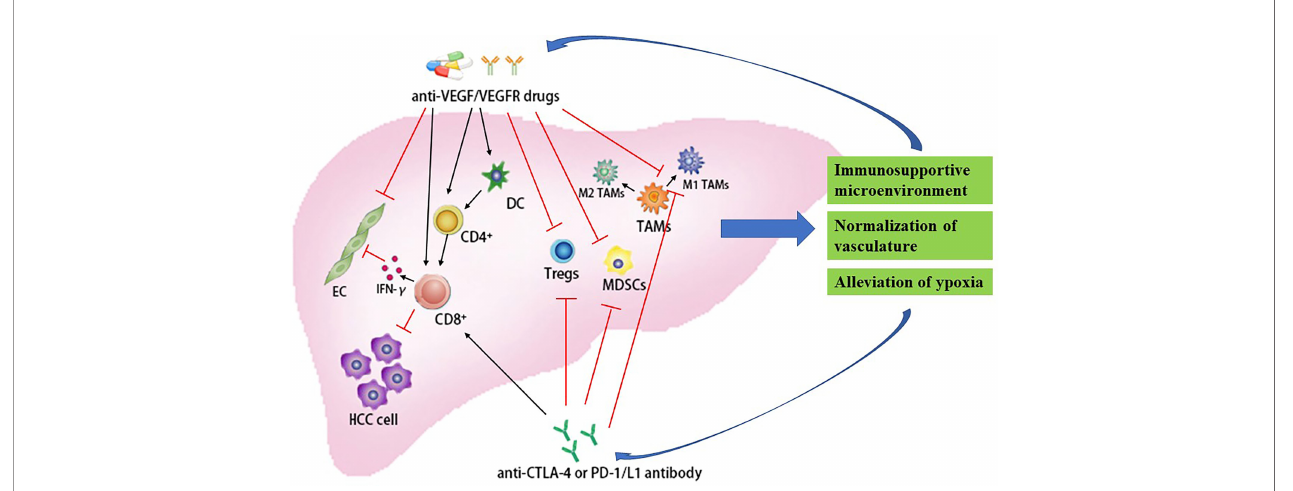
FIGURE 2 | Synergistic effect of immune checkpoint blockade in combination with antiangiogenic drugs for the treatment of HCC. CD4 + , CD4-positive T-lymphocytes; CD8 + , CD8-positive T-lymphocytes; CTLA-4, cytotoxic T-lymphocyte antigen-4; DC, dendritic cells; EC, endothelial cells; HCC, hepatocellular carcinoma; IFN- g , interferon- g ; MDSCs, myeloid-derived suppressor cells; PD-1, programmed death-1; PD-L1, programmed death-ligand 1; TMAs, tumor-associated macrophage; Tregs, regulatory T cell; VEGF, vascular endothelial growth factor; VEGFR, vascular endothelial growth factor